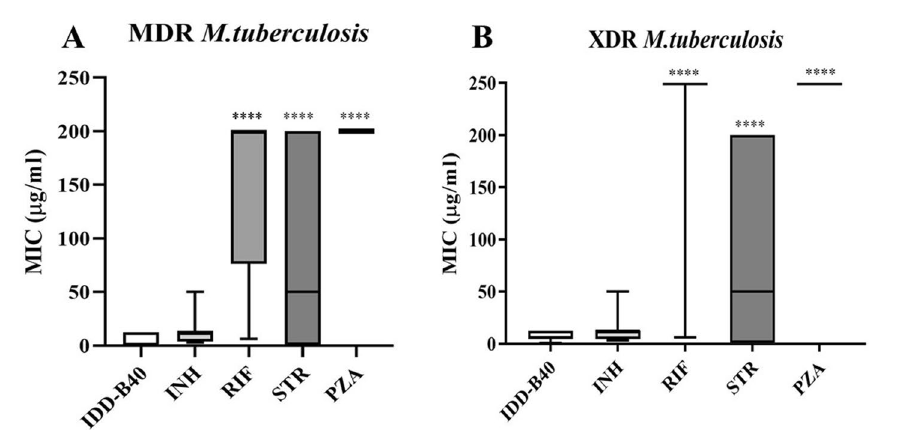
Figure 3. 50% Minimum inhibitory concentration (MIC 50 ) of IDD-B40 and control drugs [isoniazid (INH), rifampicin (RIF), streptomycin (STR) and pyrazinamide (PZA)] against clinically isolated ( A ) multidrug- resistant (MDR) and ( B ) extensively drug-resistant (XDR) strains of M. tuberculosis in Korea. The figures are shown as a box plot, in which the bottom and top edges of the box are the 25th and 75th percentiles, and the center horizontal line is the 50th percentile (median). *Statistical significance were determined in Graph Pad Prism 8.2.0 between IDD-B40 versus control drugs using an unpaired Student’s t test (* p < 0.05, ** p < 0.01, *** p < 0.001, **** p <